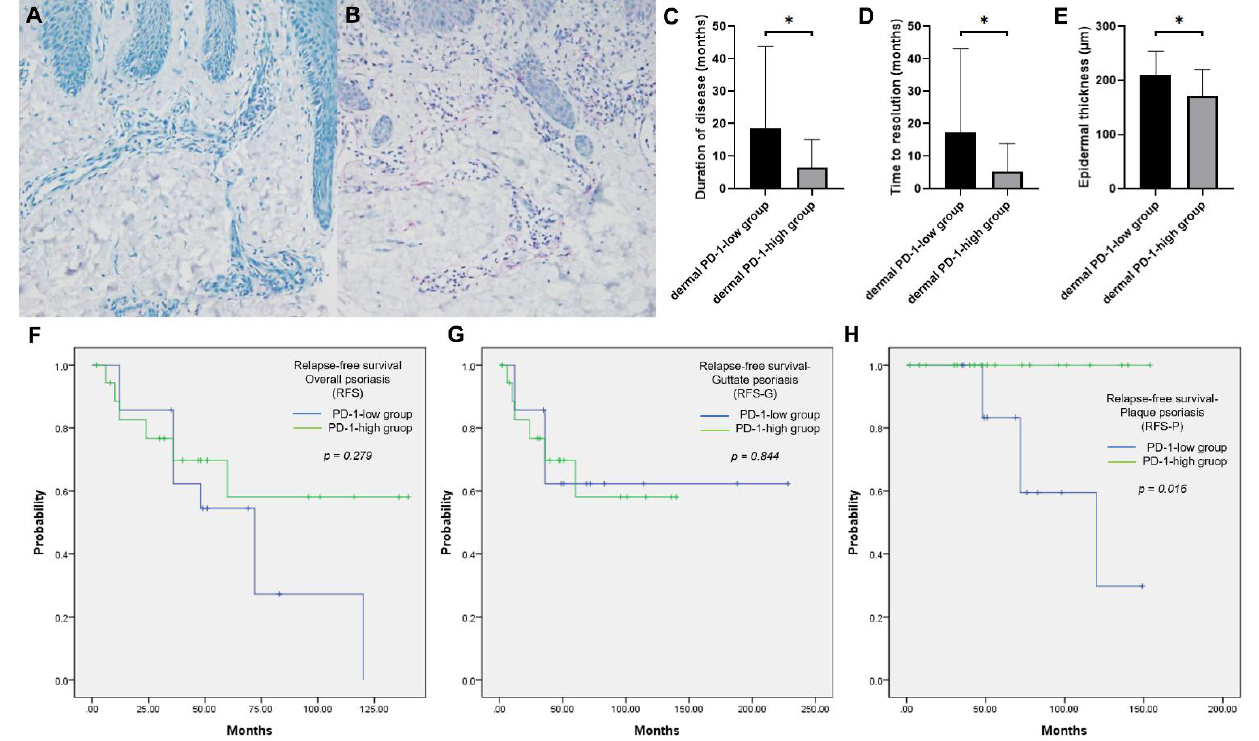
Figure 2. Clinicoprognostic and histopathological characteristics of patients with guttate psoriasis in the dermal PD-1-high and dermal PD-1-low groups. ( A , B ) Of the 33 patients, 14 and 19 were assigned to the dermal PD-1-low and dermal PD-1-high groups, respectively. ( C ) Disease duration in the dermal PD-1-low group was significantly higher than that in the dermal PD-1-high group ( p = 0.002). (D) Time to disease resolution in the dermal PD-1-low group was significantly higher than that in the dermal PD-1-high group ( p = 0.008). ( E ) Epidermal thickness in the dermal PD-1-low group was significantly greater than that in the dermal PD-1-high group ( p = 0.046). ( F ) Relapse-free survival (RFS) was not significantly different between the groups ( p = 0.279). ( G ) RFS of patients with guttate psoriasis (RFS-G) was not significantly different between the groups ( p = 0.844); ( H ) RFS of patients with plaque-type psoriasis (RFS-P) in the dermal PD-1-high group was significantly higher than that in the dermal PD-1-low group ( p = 0.016). * p < 0.05.